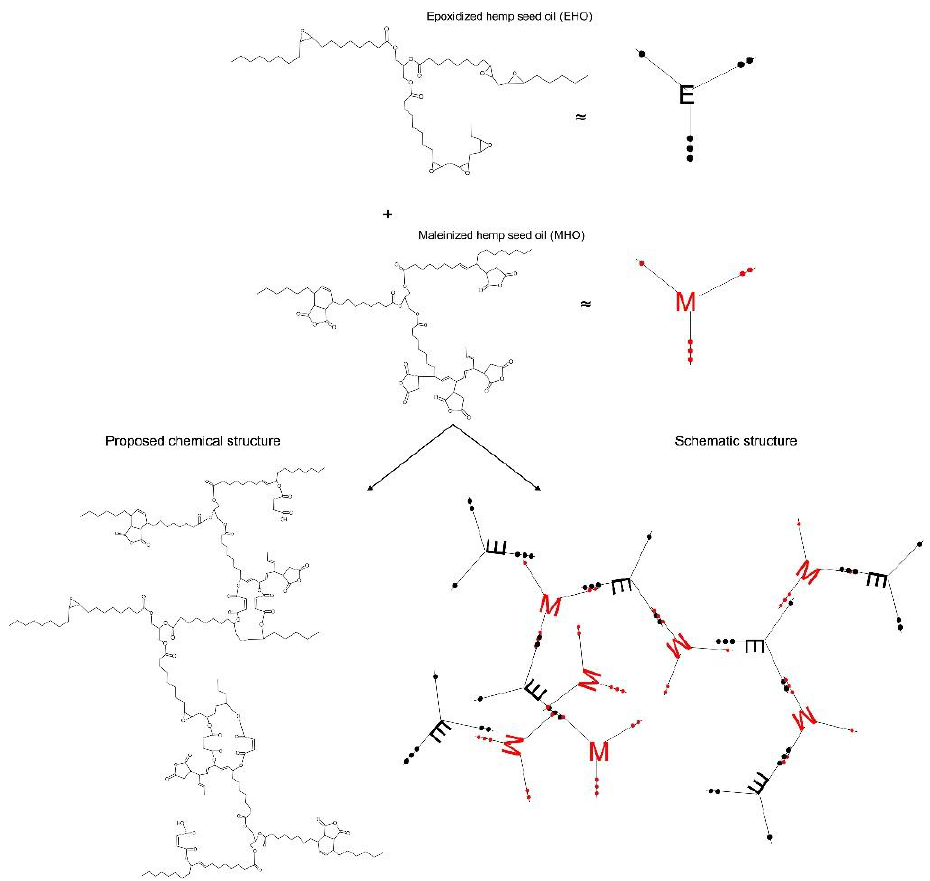
Figure 4. Epoxidized hemp oil (EHO) reaction using maleinized hemp oil (MHO) as a crosslinker. Black dots: oxirane groups ; Red dots : maleic groups.